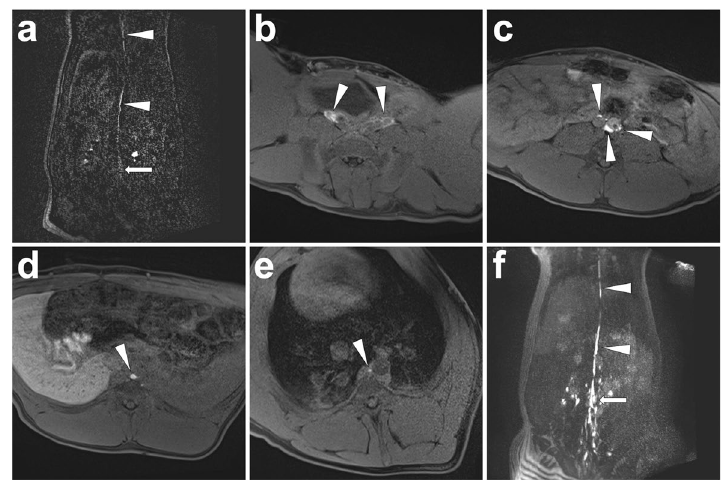
Fig. 7 Illustration of interstitial MRL in a pig model. After interstitial injection of gadoxetate disodium at the bilateral foot dorsal, a dynamic coronal 3D-TWIST scan was performed. Thirty minutes later, the definite thoracic duct ( white arrowheads ) started from cisterna chyli ( white arrow ) was visualized ( A ). Afterwards, a 3D-FLASH scan was performed, which presented the continuous lymphatic network surrounding bilateral iliac arteries and veins ( white arrowheads ; B ) to retroperitoneal lymphatic vessels ( white arrowheads ; C ) and thoracic duct ( white arrowhead ; D , E ). Coronal 3D-FLASH MIP image demonstrated a clear structure of retroperitoneal lymphatic vessels, cisterna chyli ( white arrow ), and proximal thoracic duct ( white arrowheads ) ( F ). Images were from Pig No. 11 . Abbreviations: MRL, magnetic resonance lymphangiography; 3D-TWIST, three-dimensional time-resolved angiography with interleaved stochastic trajectories; 3D-FLASH, three-dimensional fast low angle shot; MIP, maximum intensity